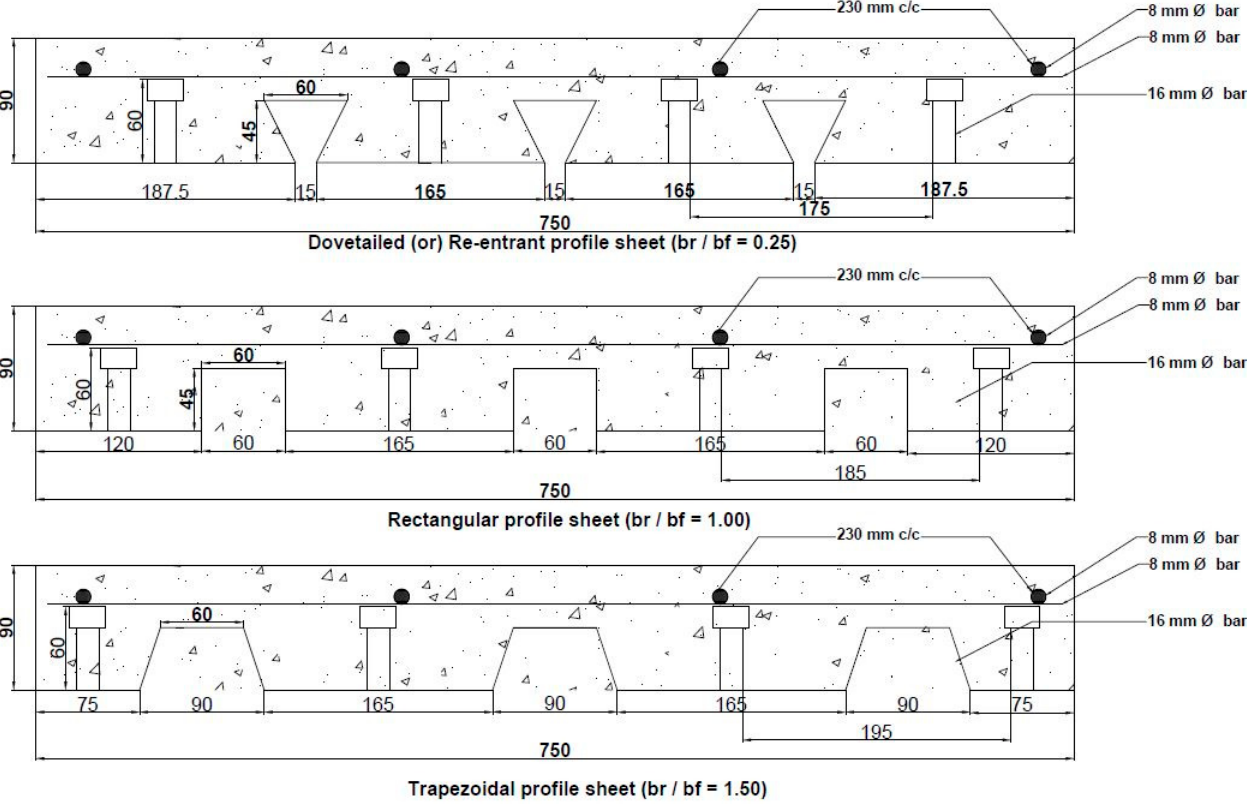
Figure 3. Dovetailed or re-entrant profiled sheet (All dimensions are in mm). Figure 4. Rectangular profiled sheet (All dimensions are in mm).